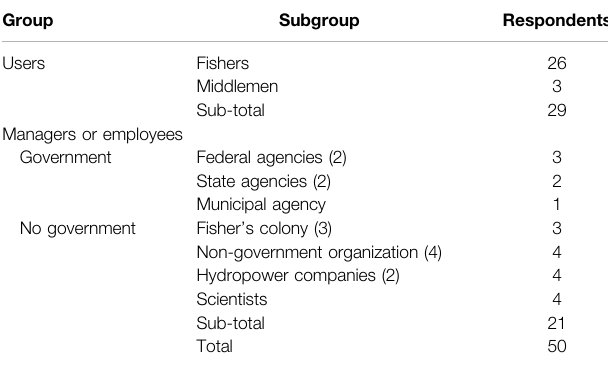
TABLE 3 | Description of the sampled number of interviewees per stakeholder group. The number of agencies interviewed is indicated in